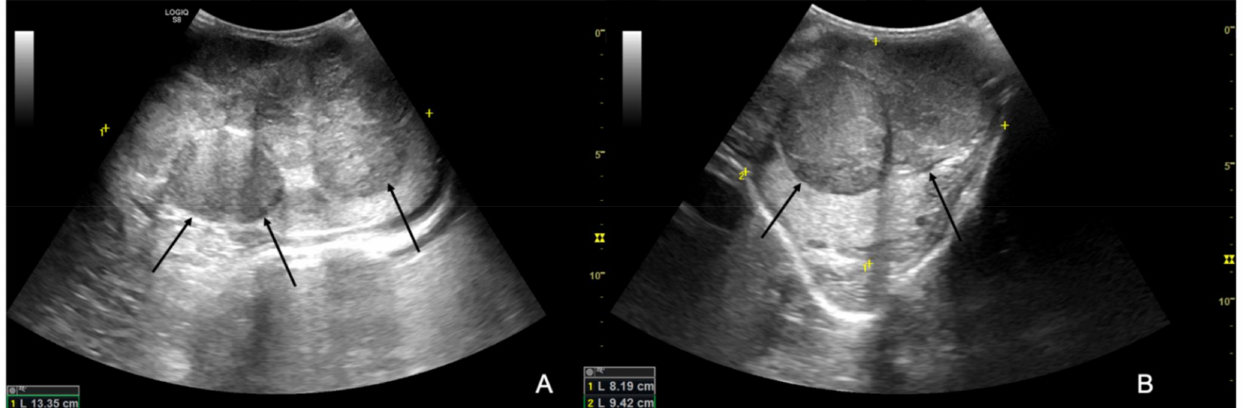
Figure 3. B-mode longitudinal ( A ) and transverse ( B ) images of the left testicle; the black arrows point at the heterogeneous and well-defined nodular lesions effacing the normal testicular